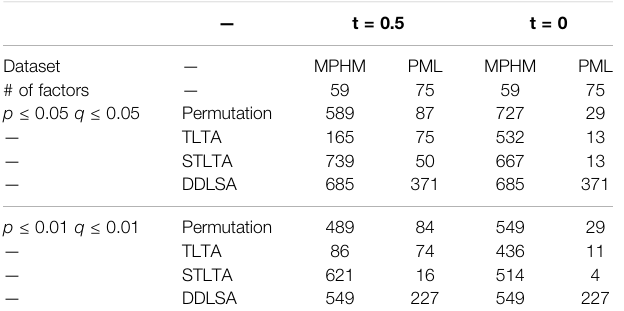
TABLE 7 | The numbers of signi fi cant correlations between OTUs found by permutation tests, TLTA, STLTA and DDLSA for different data sets and signi fi cance levels.